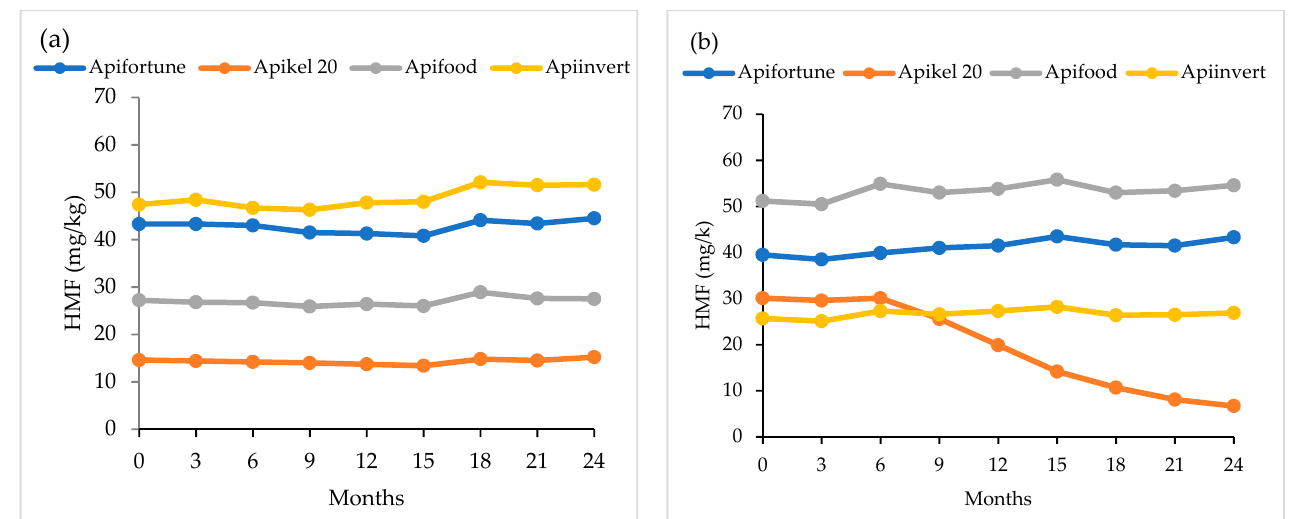
Figure 3. Changes of HMF content in syrups during storage at about 4 °C ( a ) from 2012 and ( b ) from 2013. Fructose and glucose contents in starch and inverted saccharose syrups did not change significantly in comparison to fresh syrups even after 24 months of storage (Figures